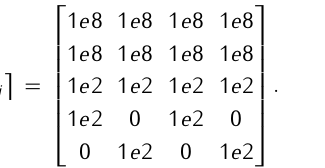
Table 6. The first eight natural frequency parameters ω restrained against rotation and translation, ( a/b = 1 , k